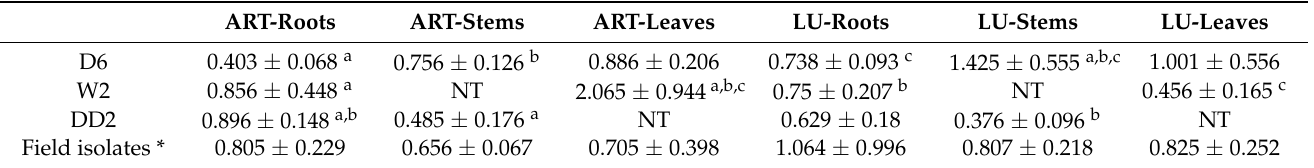
Table 5. Mean of mean sum FIC 50 s values across all fixed ratios for artemether and lumefantrine combined with S. longipedunculata extracts against strains of P. falciparum